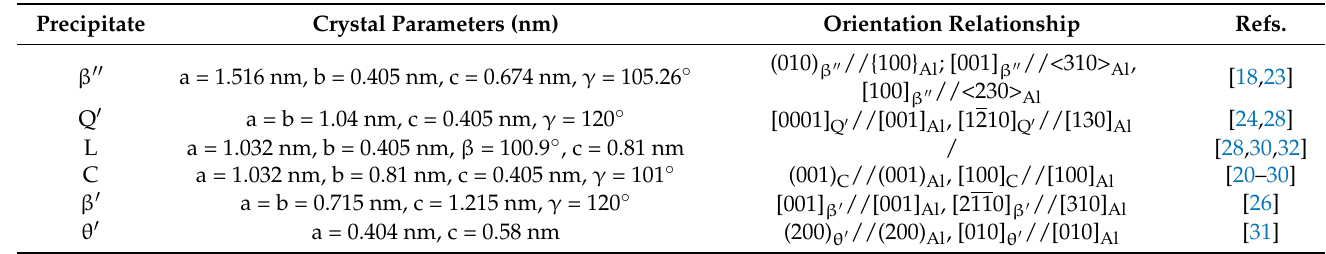
Table 1. The crystal parameters and ORs of precipitates reported in Al-Mg-Si(-Cu) alloys. Precipitate Crystal Parameters (nm) Orientation Relationship